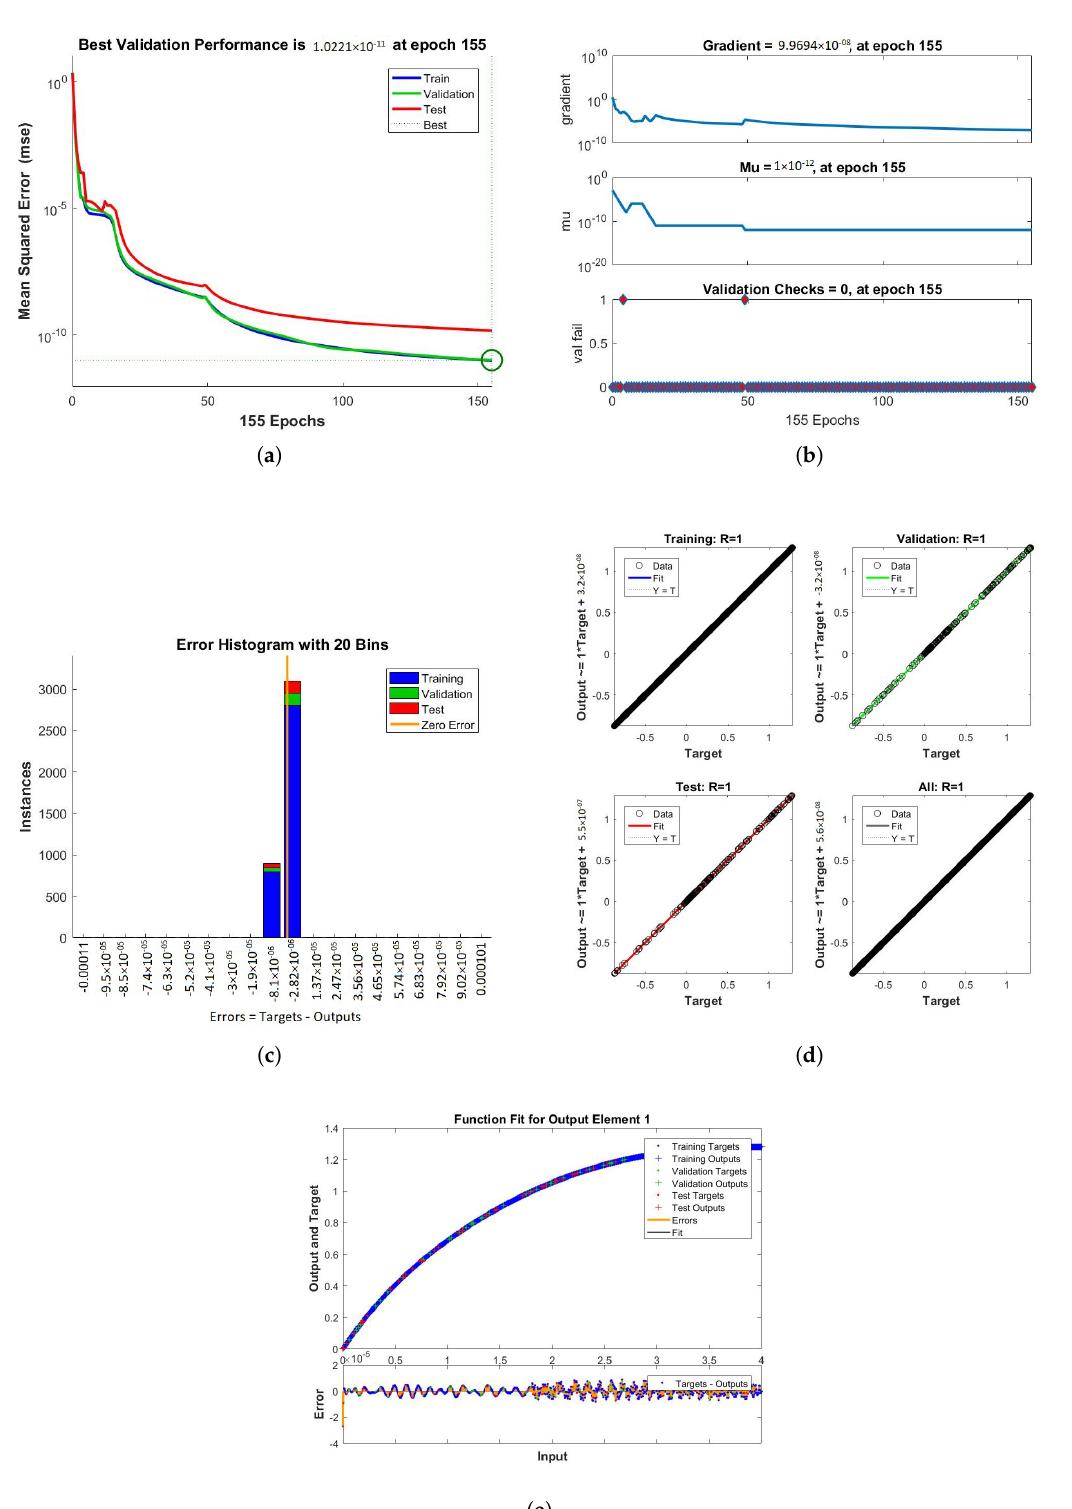
Figure 11. Performance, training, error histogram, regression, and fitness graphs of our system were obtained through LMBNN while using the value of rotation parameter K = 0.3. ( a ) Performance. ( b ) Training. ( c ) Error Histogram. ( d ) Regression. ( e )